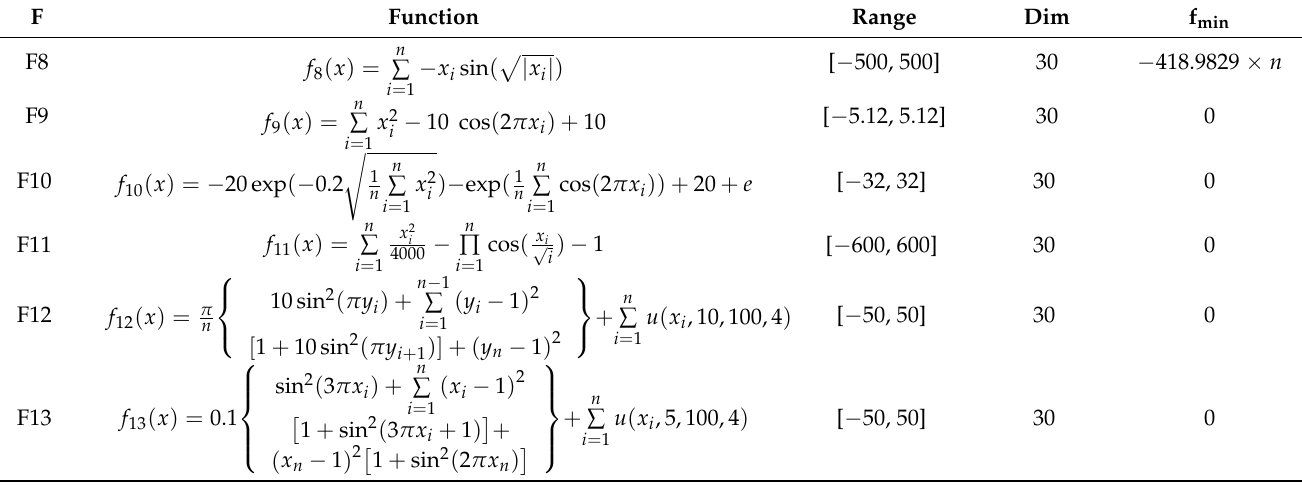
Table 3. Multi-peak test functions.